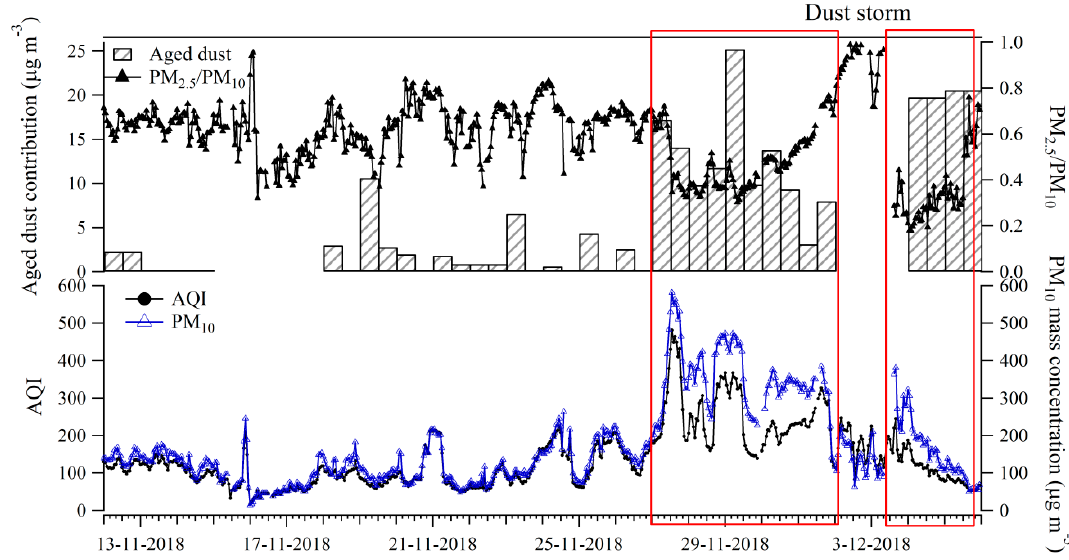
Figure 8. Time series of PM 10 , PM 2.5 / PM 10 , AQI, and aged dust contribution to PM 2.5 obtained by PMF.